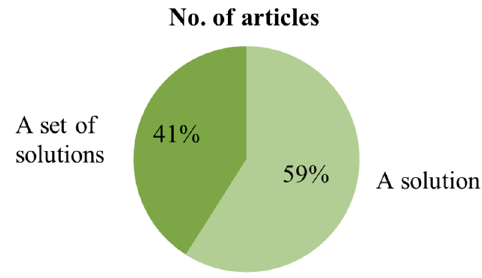
Figure 5. Number of articles targeting at different solution numbers for MOO.